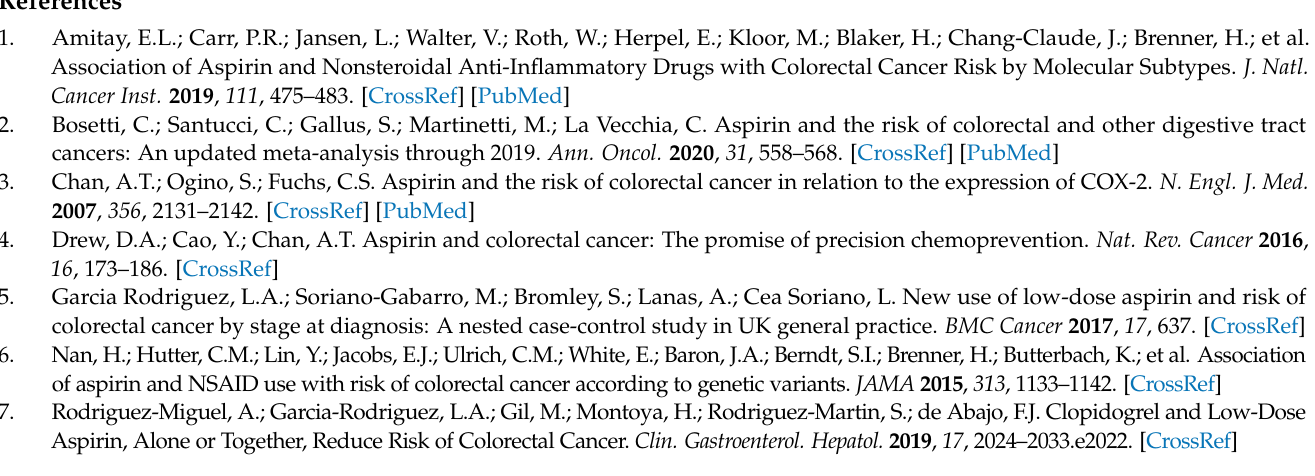
Matched Pair balancing, Table S2: Patient characteristics of tumors that underwent RNA sequencing, Table S3: Hotspot mutations, Table S4: Differentially expressed genes by tumor response, Table S5: Differentially expressed genes by aspirin use, Table S6: Gene set enrichment analysis based on tumor response, Table S7: Gene set enrichment analysis based on aspirin use, Table S8: Cell type estimation analysis based on tumor response, Table S9: Cell type estimation analysis based on aspirin